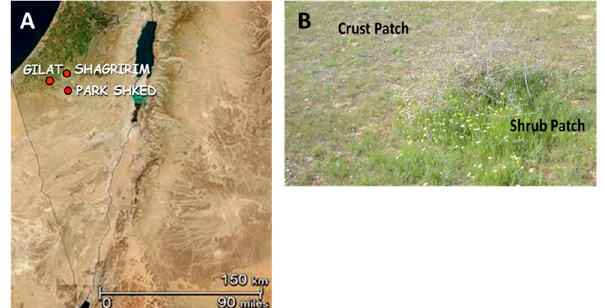
Figure 1. Study site and basic biotic landscape unit. ( A ). Northern Negev, semi-arid LTER study sites: Gilat, Shagririm, Park Shaked. Average rainfall ~150mm annually, daily average temperature: winter 6–8 °C and summer 32–34 °C (Source: Google Earth). ( B ) The basic biotic landscape units in the Israeli Negev: the biological soil crust (biocrust) is a source of runoff generation, while the shrub is a sink for water, soil and nutrients. The biocrust patch is deprived of vegetation while the annual plants flourish in the shrub patch (Source: Moshe Shachak, Park Shaked LTER—Spring season).